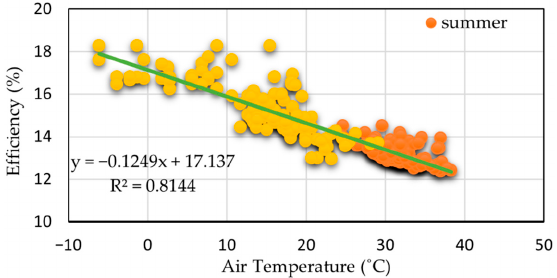
Figure 9. Relation between efficiency and air temperature.